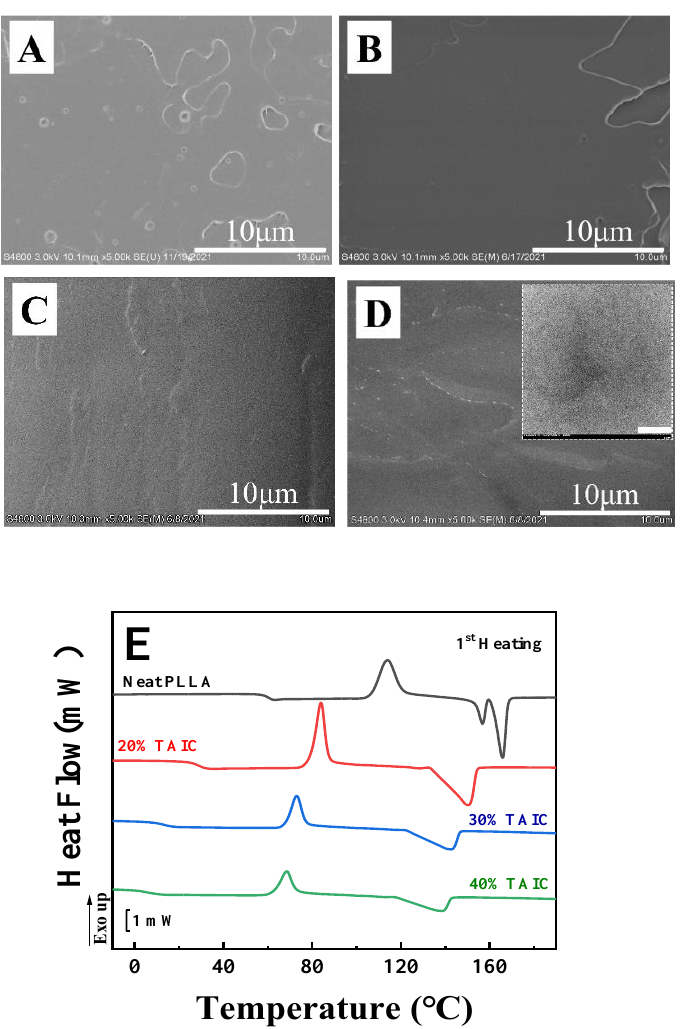
Figure 1. SEM images ( A – D ) and DSC curves ( E ) of cross section of PLLA/TAIC blend films with various compositions: ( A ) — neat PLLA, ( B ) — PLLA/TAIC (80/20), ( C ) — PLLA/TAIC (70/30), ( D ) — PLLA/TAIC (60/40). Inset in ( D ) shows the TEM image of the corresponding specimen in which the scale bar is 500 nm.